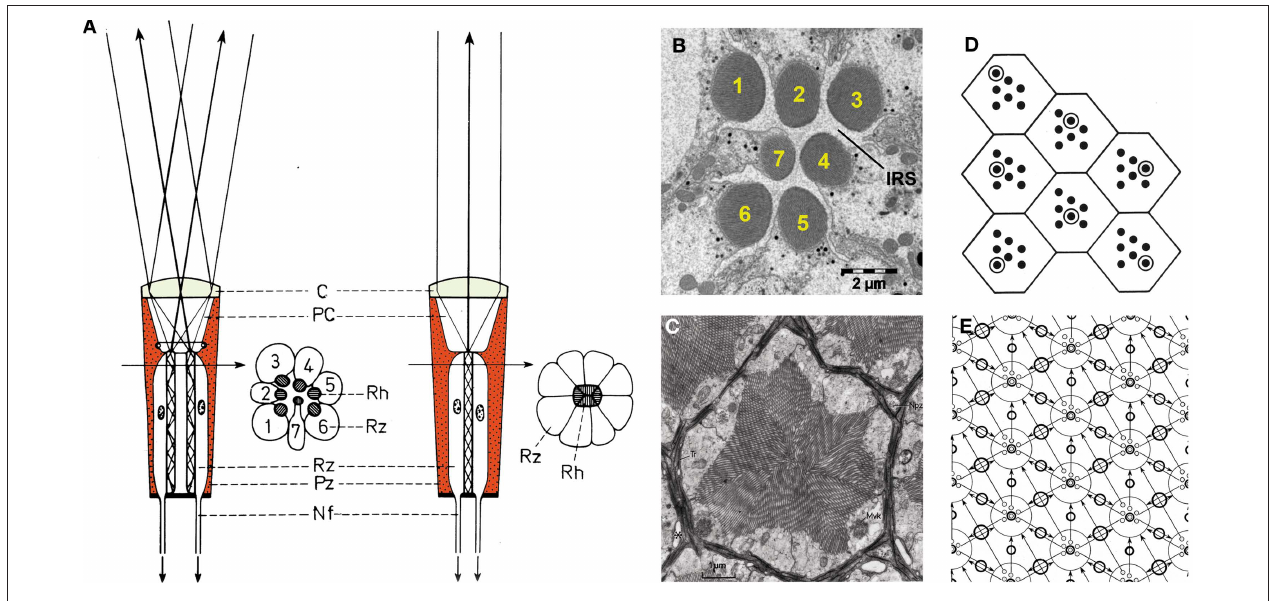
FIGURE 2 | Compound eyes with closed and open rhabdoms. (A) Schematic representation of an ommatidium with open rhabdom (left) and closed rhabdom architecture (right) (modifi ed from Kirschfeld, 1971). (B) EM cross-section of Drosophila ommatidium with open rhabdom architecture. (C) EM cross-section of Ephestia ommatidium in the region of distal tracheole ends with closed rhabdom architecture (from Fischer and Horstmann, 1971).